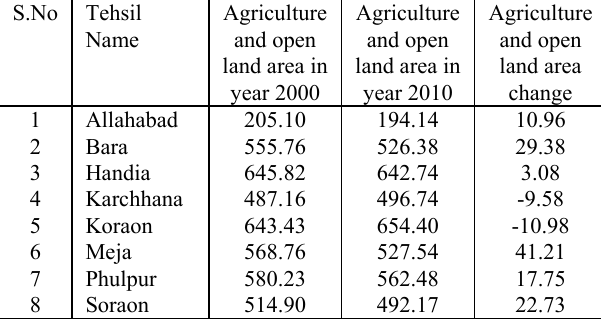
Table 3. Tehsil wise change in agriculture and open land area from year 2000 to 2010. All values of area are in km 2 .